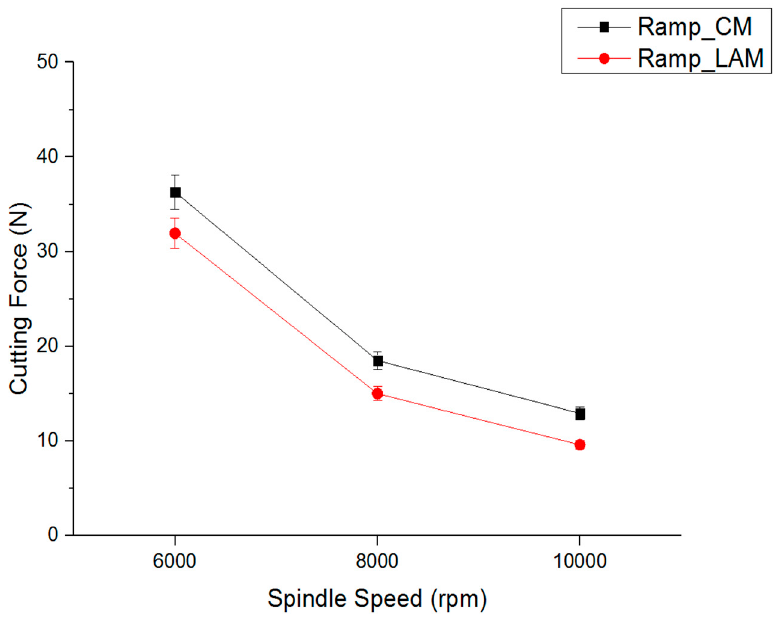
Figure 15. Experiment results by the feed rate 140 mm/min in ramp milling.